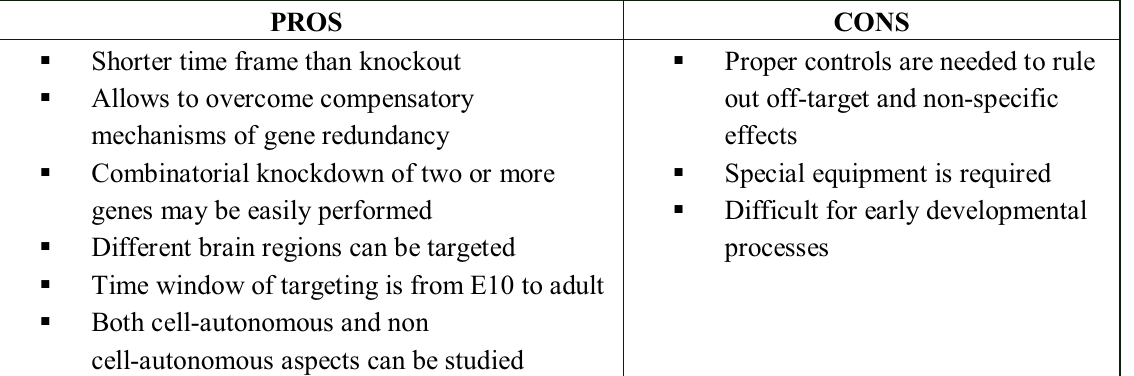
Table 2. Usage of knockdown in utero experiments to study the developing brain: pros and cons.